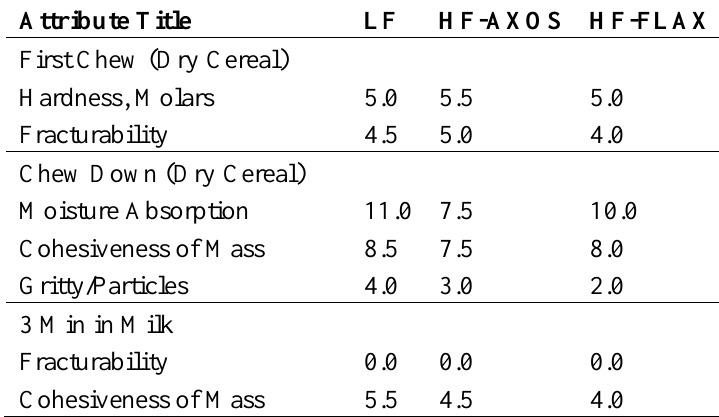
Table 2. Sensory characteristics of RTE flaked cereal dry and with milk. Results were collected as panel consensus a .